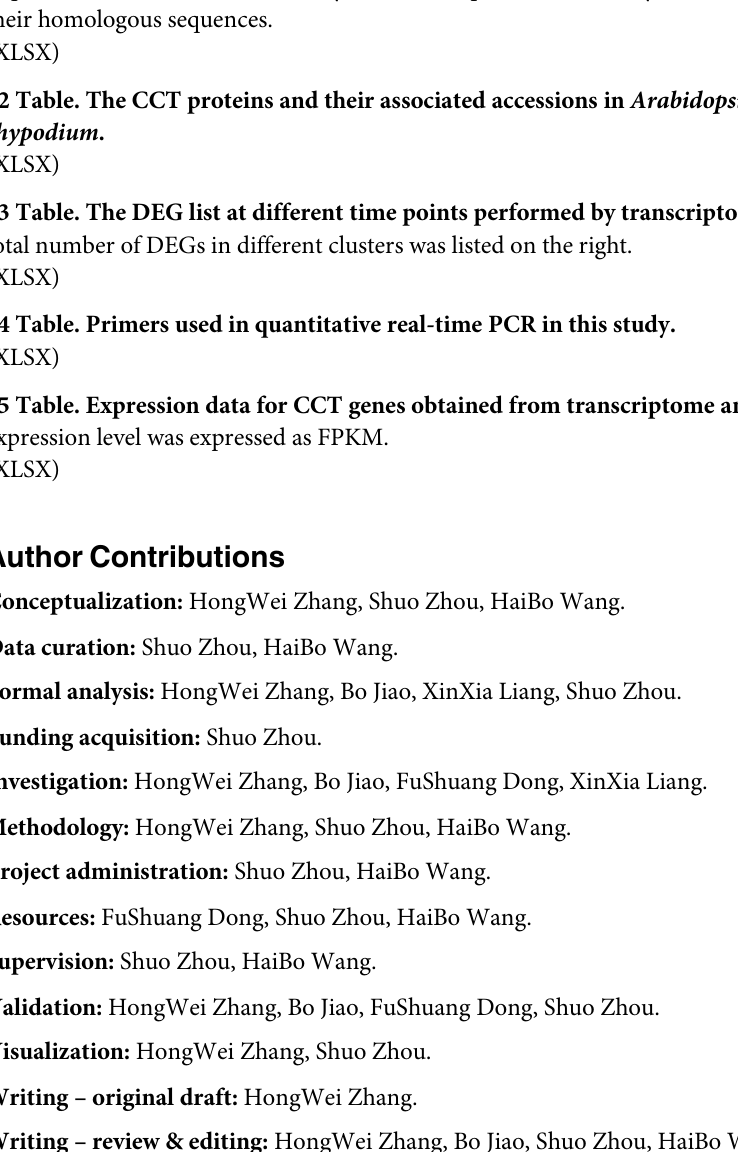
S1 Table. The detailed information of CCT genes characterized in this study. a The sequences were FGENESH+ reanalyzed. b The sequences were analyzed manually according to their homologous sequences. S2 Table. The CCT proteins and their associated accessions in Arabidopsis , rice, and Bra- chypodium . S3 Table. The DEG list at different time points performed by transcriptome analysis. The total number of DEGs in different clusters was listed on the right. S4 Table. Primers used in quantitative real-time PCR in this study. S5 Table. Expression data for CCT genes obtained from transcriptome analysis. The expression level was expressed as